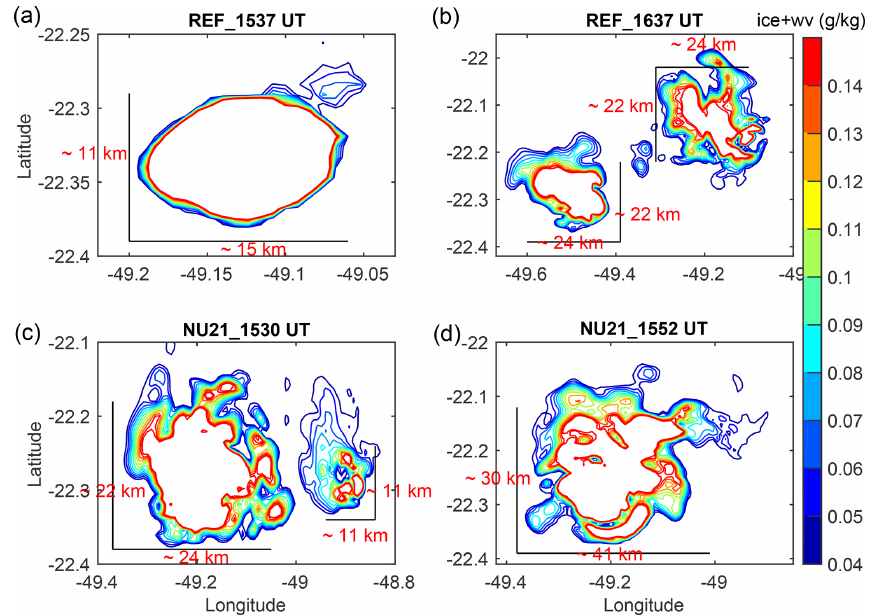
Figure 6. Size of the overshooting plumes at the 380K isentropic level, shown for REF (a, b) at 15:37UT and 16:37UT, and NU21 (c, d) at 15:30 and 15:52UT, respectively. These times are selected from Table 1. The colour contours show certain levels from 0.04 to 0.14gkg − 1 of total H 2 O content to highlight the outer part of the overshooting plumes. The solid black lines give the approximate range of each figure in kilometres.